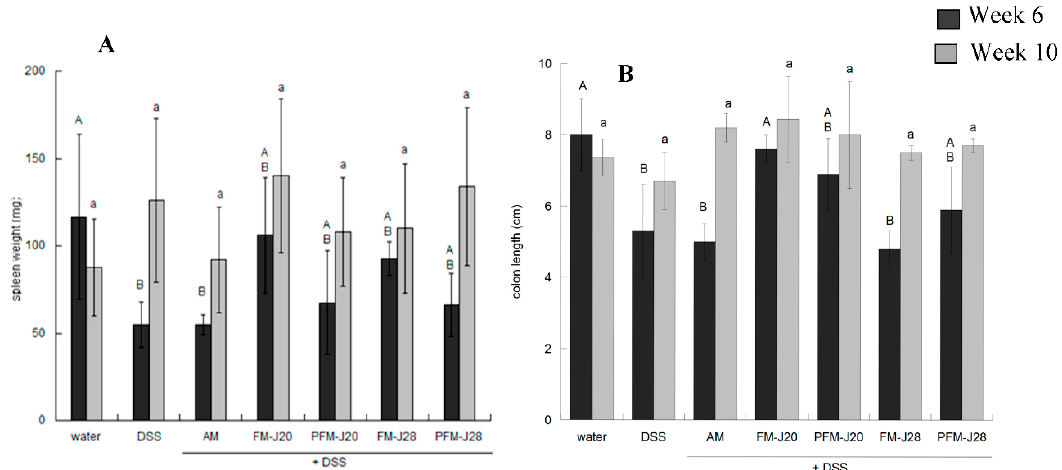
Figure 2. Effect of dextran sulfate sodium and fermented milk administration on spleen weight ( A ) and colon length ( B ) at Weeks 6 (black) and 10 (grey). Bars with an uppercase letter indicate statistical differences at Week 6 among treatments, and bars with a lowercase letter indicate statistical differences at Week 10 according to the Tukey–Kramer test ( p < 0.05). The values are the means ± SD ( n = 5).